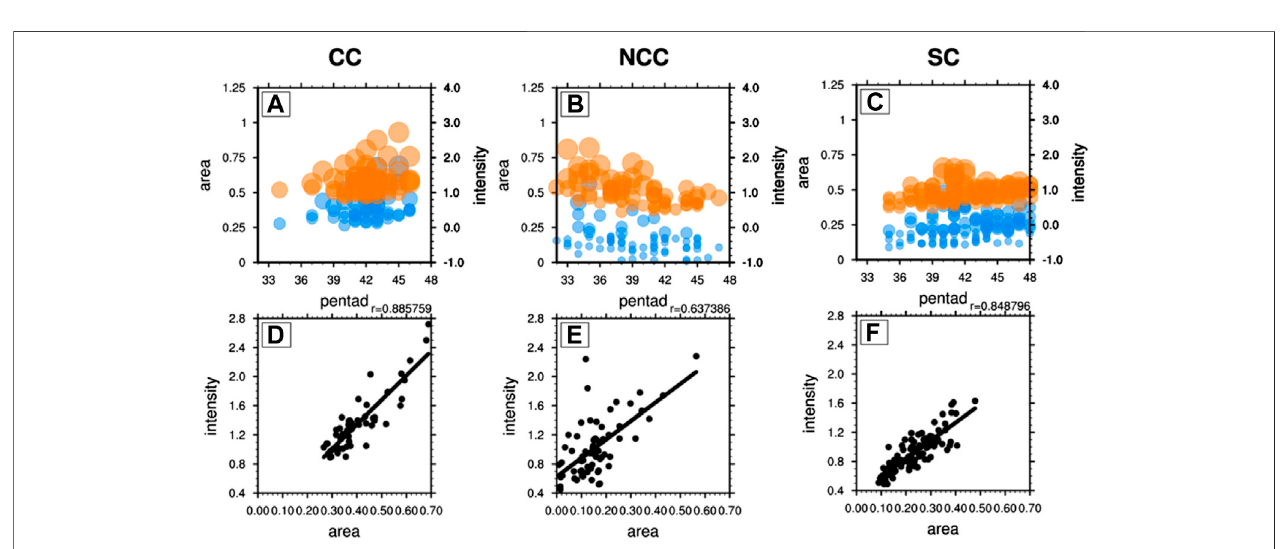
FIGURE 4 | Temporal distributions of area (blue dot) and intensity (orange dot) (unit: ° C per pentad) of RPHWs during summer (A – C) and their relationship according to scatter plots (D – F) in CC (A, D) , NCC (B, E) , and SC (C, F) . In (A – C) , the larger the dot is,the larger the area and intensity are. In (D – F) , the black line and r are the linear regression line and correlation coef fi cient, respectively between area and intensity of RPHWs, and they are all exceed the 95% con fi dence level.